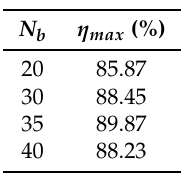
Table 3. Influence of blade number on the efficiency of 0.53 kW